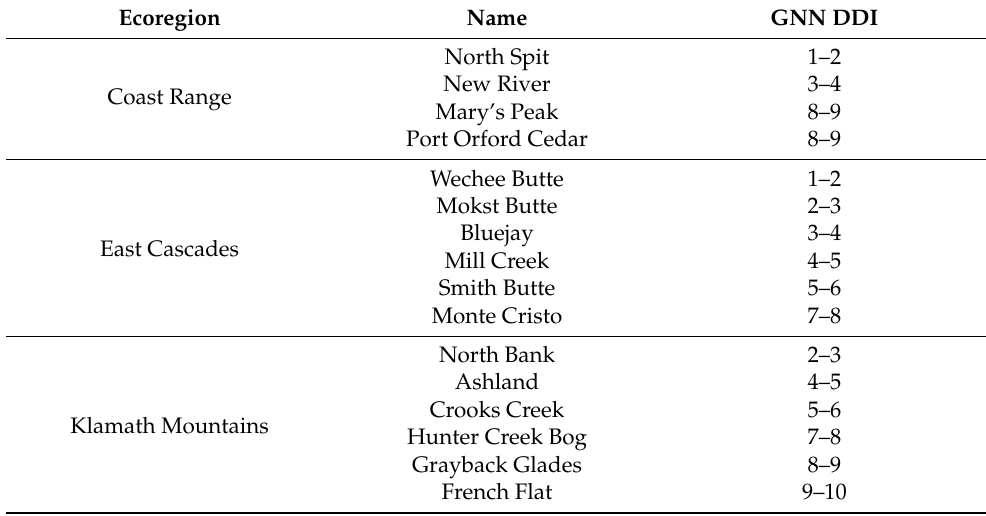
Figure 1. Distribution of 27 natural areas in Oregon and Washington used to evaluate metrics of structural complexity derived from Terrestrial LIDAR scans collected between August and October, 2014. Table 1. The ecoregion, name, and Landsat image gradient nearest neighbor diameter diversity index (GNN DDI) for our 27 study stands.